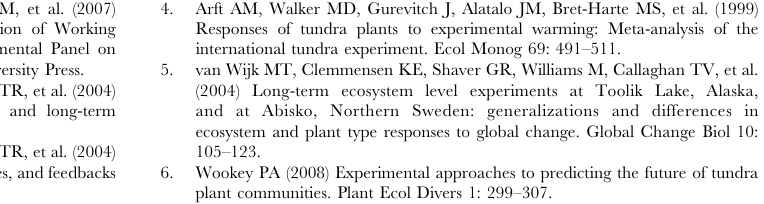
Table S1 Results of ANOVAs (F and P values) on the number and length of branches of cohort of the same age (up to 12